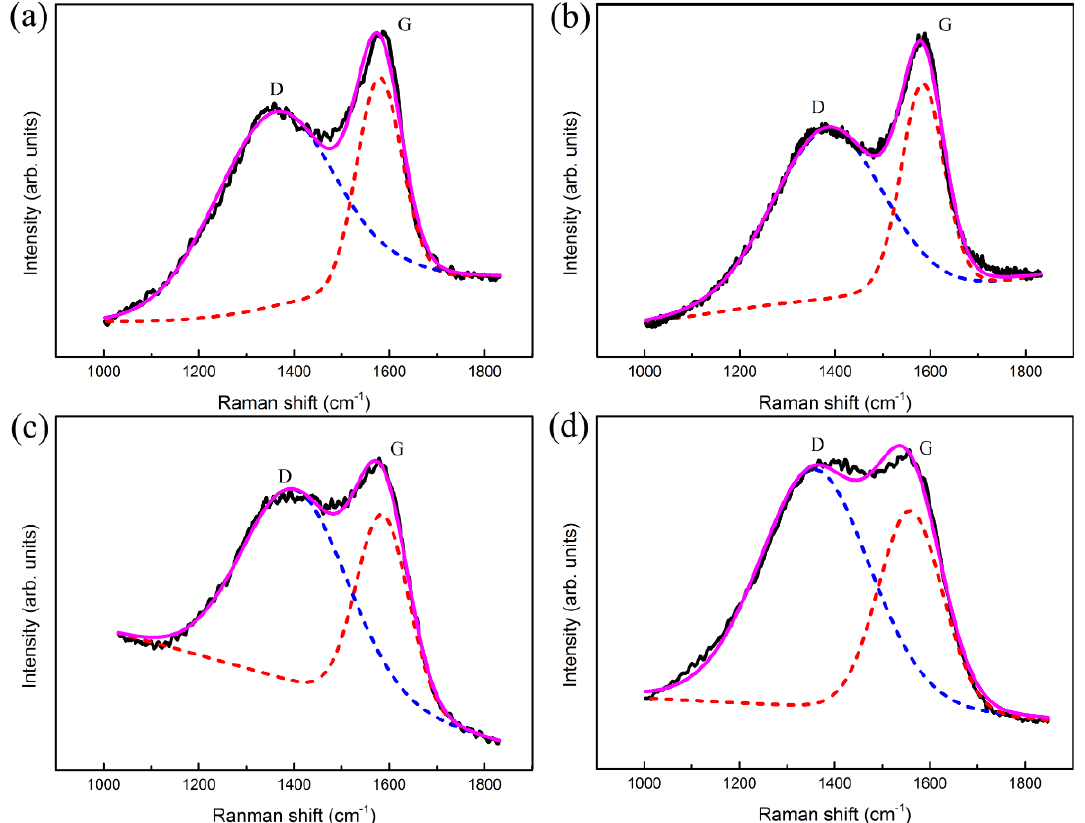
Figure 4. Surface SEM morphology of Ti-DLC coatings with Ti transition layer thickness ( t 0 ): ( a ) 0 μm, ( b ) 0.5 μm, ( c ) 1.1 μm and ( d ) 2.8 μm.